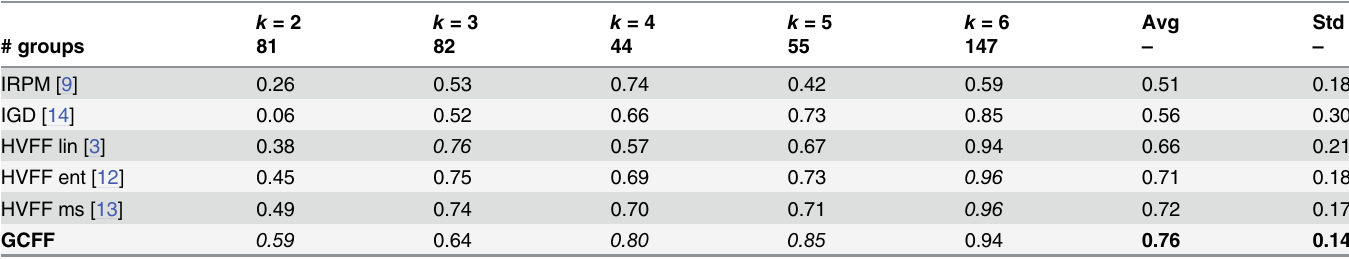
Table 7. Cocktail Party — F 1 score VS . cardinality. ( T =